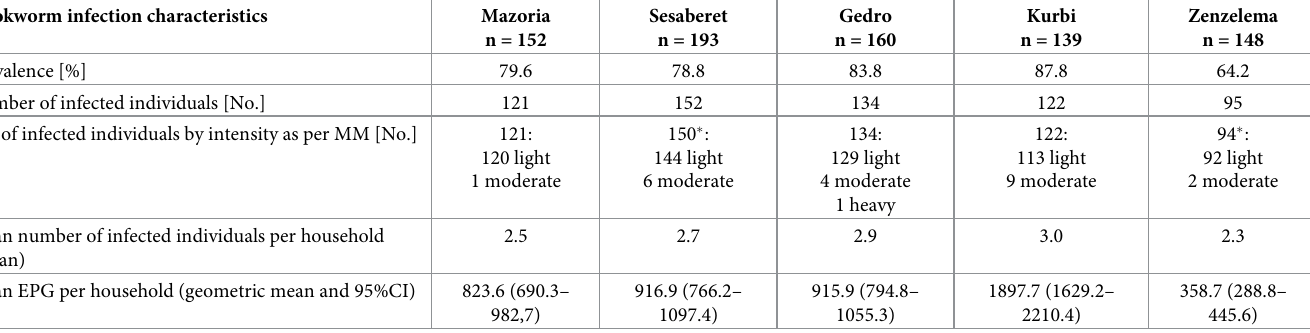
Table 3. Hookworm infection status of the participants of the study from the five villages, Kurbi, Gedro, Mazoria, Sesaberet and Zenzelema (Amhara State, Ethiopia). Hookworm infection